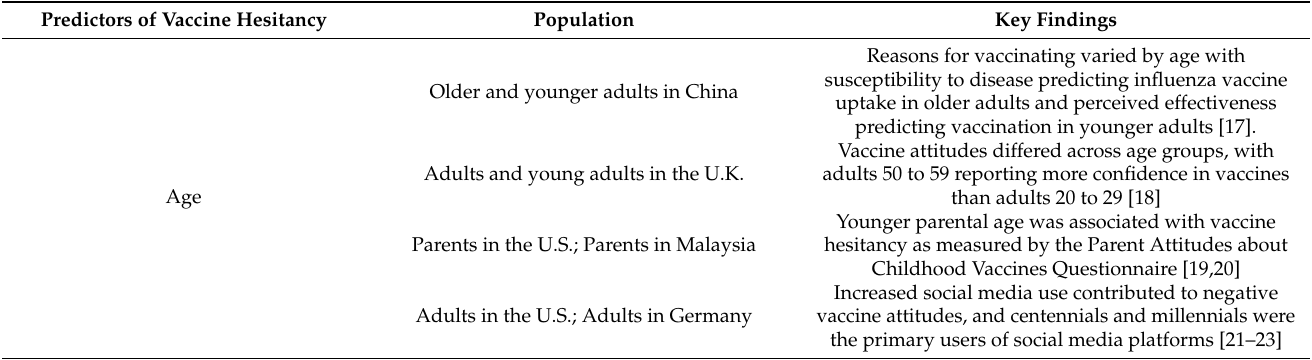
Table 1. Summary of key findings organized by predictor and by